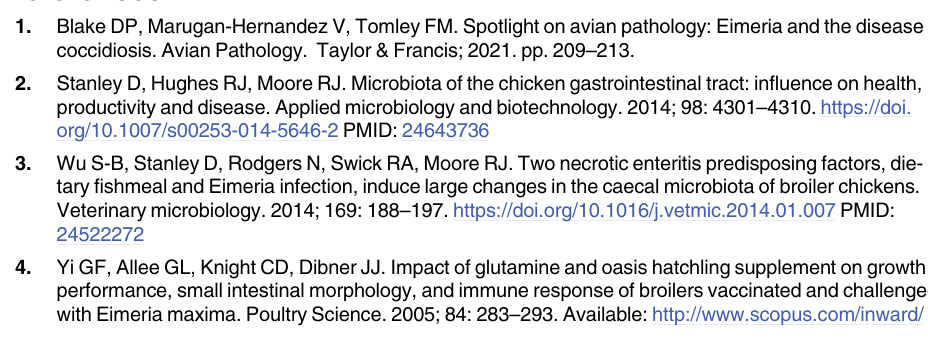
S1 Table. Ingredient formulae and chemical composition of experimental diets according to the rearing period. S2 Table. Number of reads that passed through each step of quality control for the experi- ment testing seven feed additives: Enramycin (8 ppm), virginiamycin (16.5 ppm), tylosin (55 ppm), CNSL–castor oil (CNSL-CO) at different doses (0.5, 0.75, and 1.00 kg/t), and the control diet (without additives) of broilers cecum samples at 28 and 42 d of trial with 12 replicates. S3 Table. Relative abundance at phylum, family, and genera levels present in the experi- ment. The experiment tested seven feed additives: enramycin (8 ppm), virginiamycin (16.5 ppm), tylosin (55 ppm), CNSL–castor oil (CNSL-CO) at different doses (0.5, 0.75, and 1.00 kg/t), and the control diet (without additives) of broilers cecum samples at 28 and 42 d of trial with 12